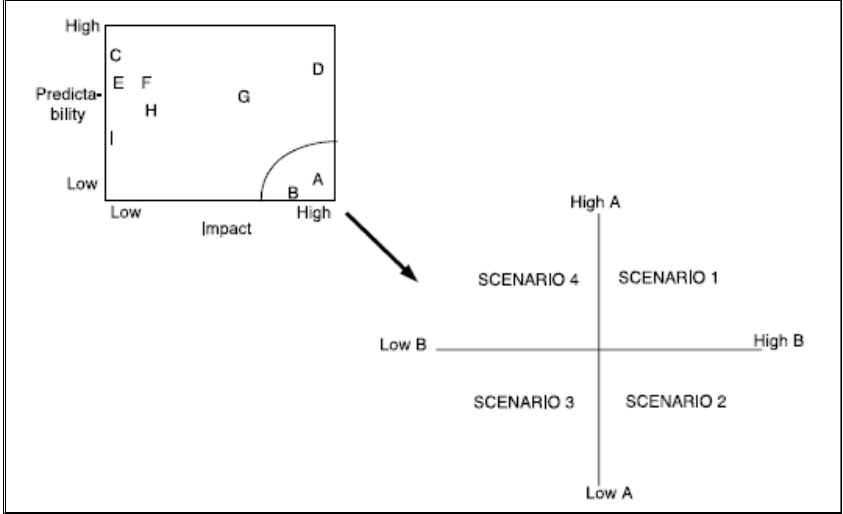
Figure 2. From drivers to critical uncertainties and scenarios. From Postma and Liebl